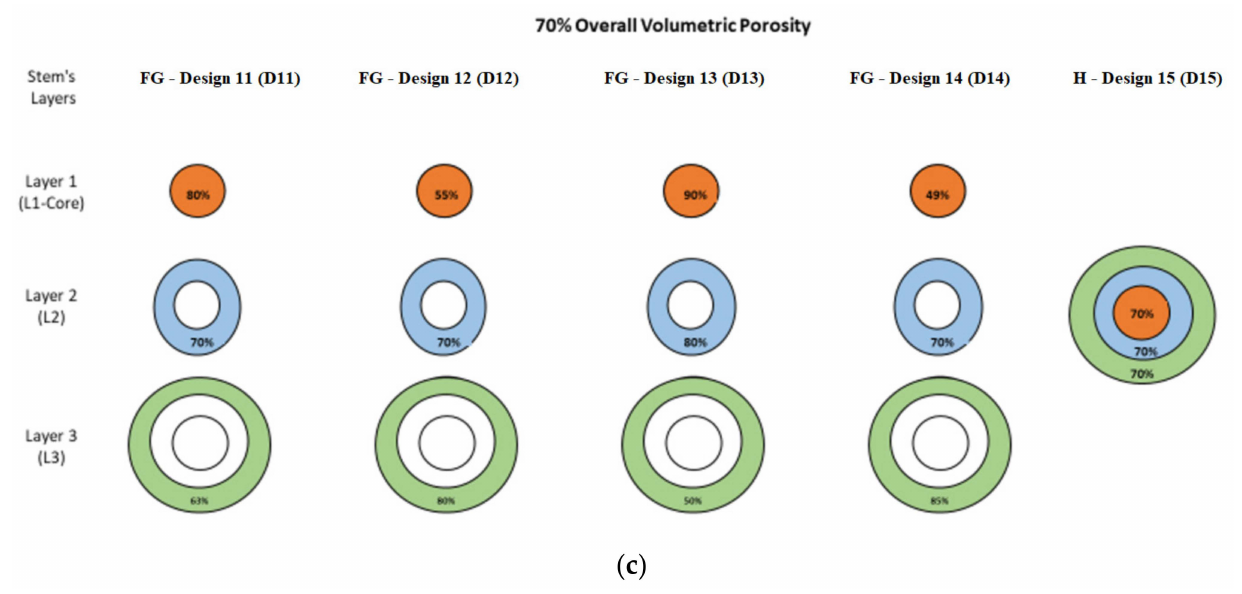
Figure 2. Design groups of porous functionally graded (FG) and homogeneous designs introduced to stem’s redial layers: ( a ) average porosity of 30%, ( b ) average porosity of 50%, and ( c ) average porosity of